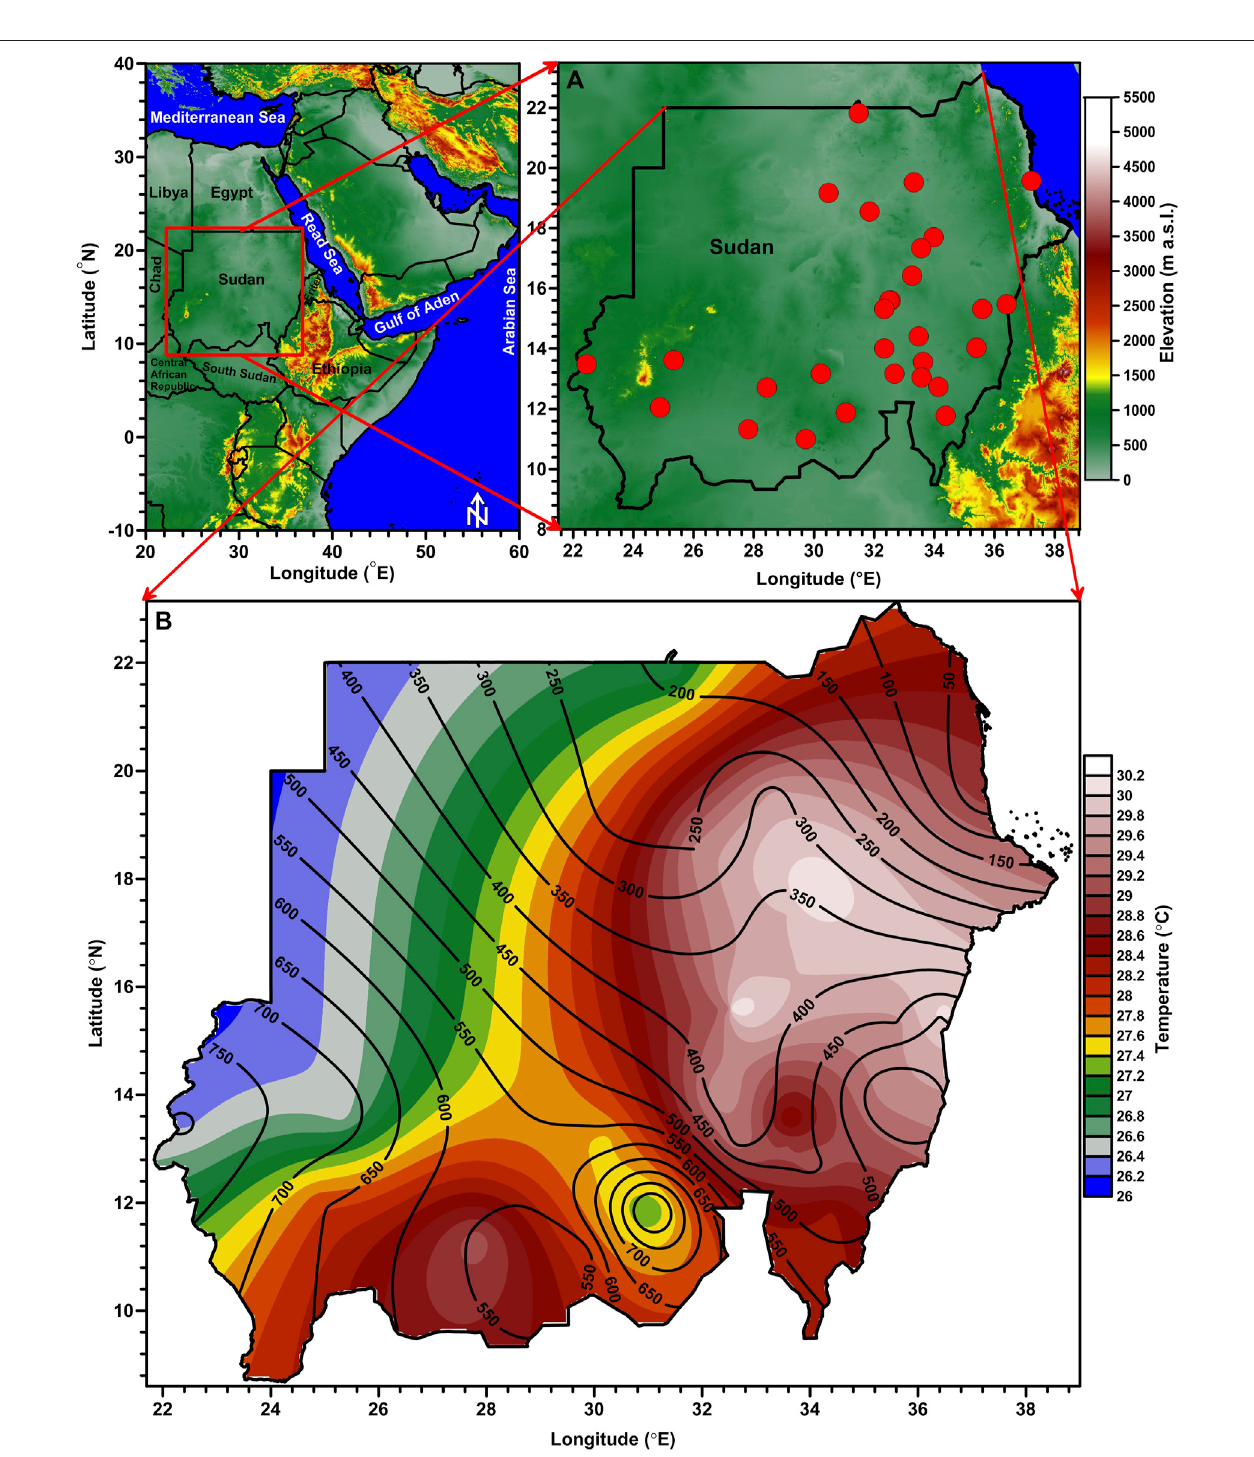
FIGURE 1 | The study region ’ s location, spatial distribution of stations, elevations, and mean temperature. The contour lines in Figure 2B represent the elevation distribution in the study region. The mean temperature is calculated over the period 1981 – 2010.